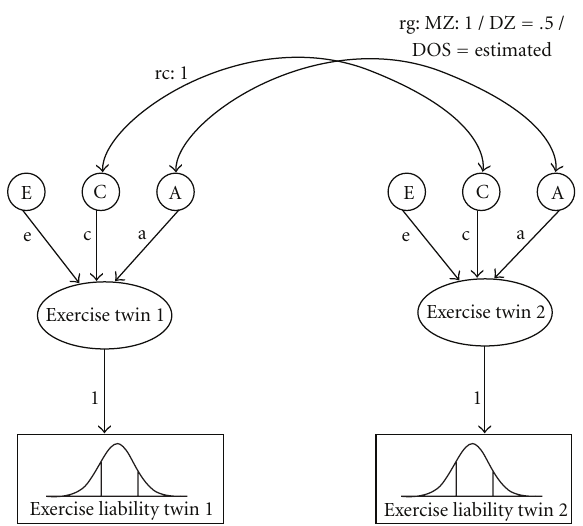
Figure 1: Univariate liability threshold model for twin data. Exer- cise behavior was measured with 3 categories (hence 2 thresholds are estimated). The total variance in liability is one and is modeled as caused by latent factors A (additive genetic influences), C (common or shared environment) and E (unique environment). The square of path coe ffi cients a, c, and e gives the variance due to A, C and